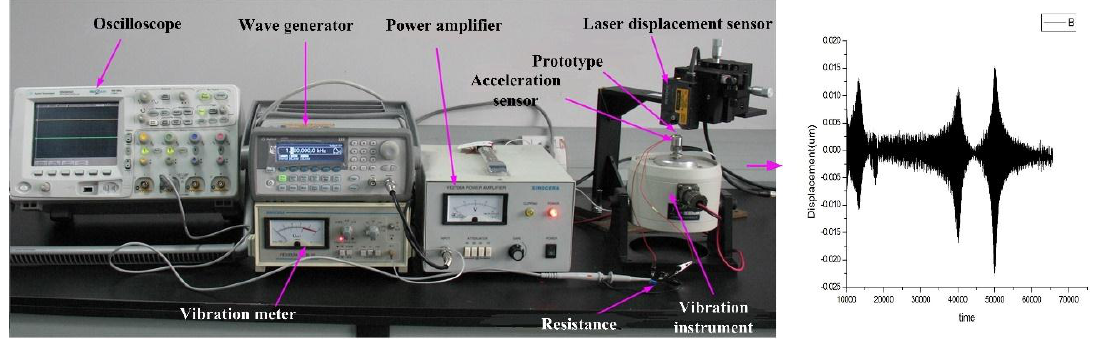
Figure 13. Dynamic response measurement system.